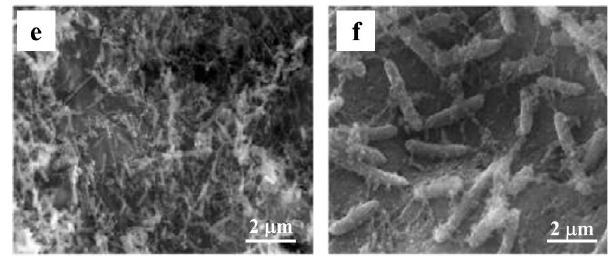
Figure 9. ( a ) Schematic and ( b , c ) SEM image of artificial conductive biofilm. Shewanella cells